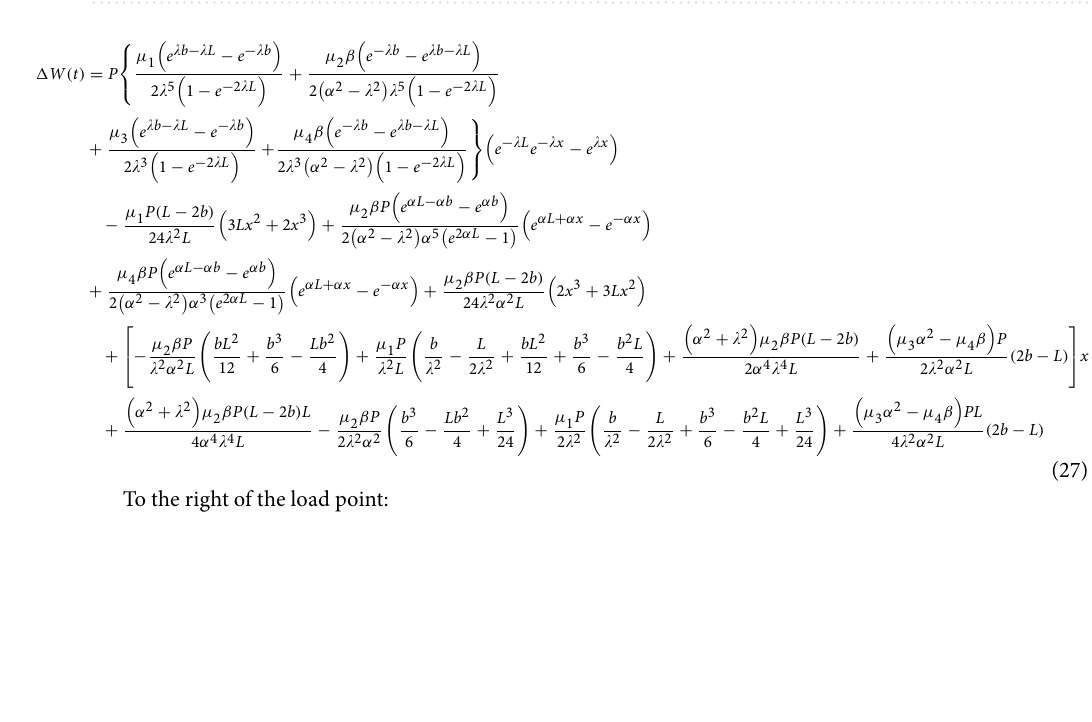
Figure 7. Coupling influence of stiffness under creep on displacement